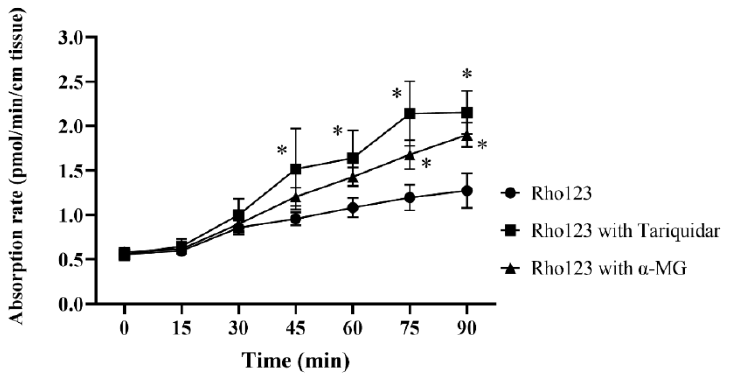
Figure 6. Absorption rate of Rho123 (10 µM) from mucosal to serosal across the everted ileum sac in the presence of tariquidar or α-MG at concentrations 100 nM or 200 µM, respectively. Each value represents the mean ± S.E. * Significantly different from Rho123 ( p < 0.05).